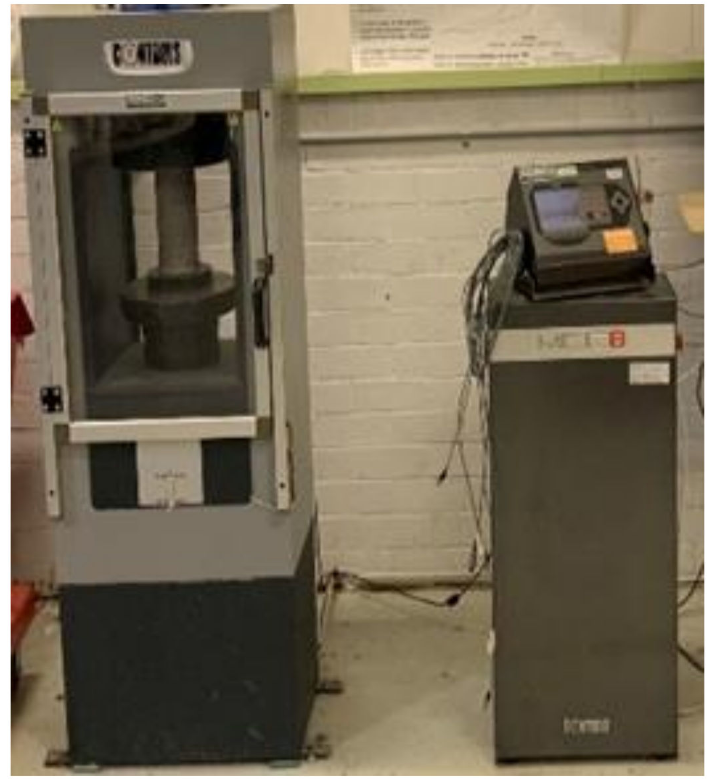
Figure 5. Compressive strength test specimen.